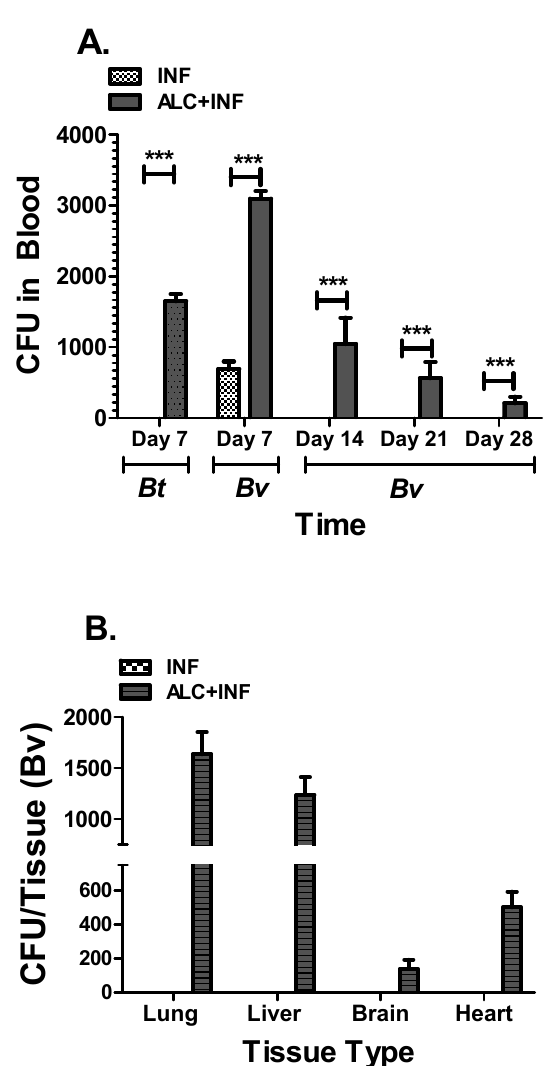
Figure 2. Whole blood and tissue colony forming units (CFUs) from mice infected with B. thailandensis ( Bt ) or Burkholderia vietnamiensis ( Bv ). ( A ) Blood was collected weekly post infection and Burkholderia species were grown on LB media plates for 48 h at 37 °C to determine CFUs. ( B ) Tissues were collected and homogenized at day 28 from Bv-infected mice (INF) and mice infected with Bv and exposed to alcohol (ALC+INF) to determine bacterial tissue burden. Bars represent the average CFUs per treatment with SEM. Horizontal line with asterisk (*) represents statistical comparison to the INF group determined by Student’s t -test, n = 3. ** p ≤ 0.01, *** p ≤ 0.001.